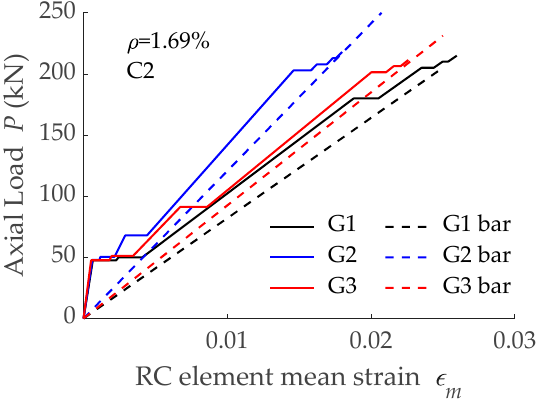
Figure 11. Load-mean strain curves obtained with different GFRP reinforcing bars (having different bond performance) embedded in concrete C2.